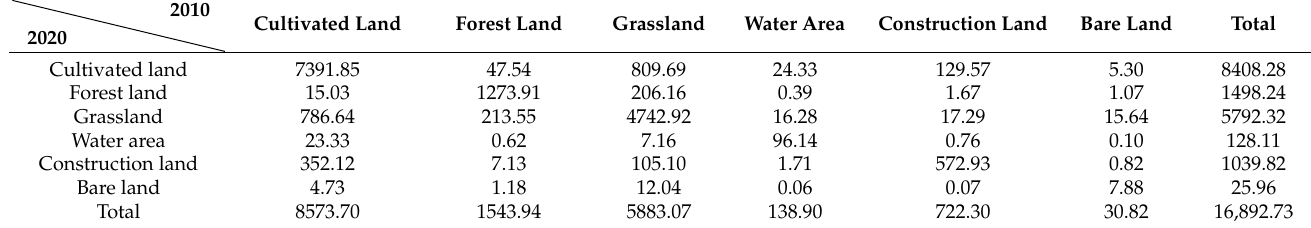
Table 10. The land use transfer matrix in Hohhot from 2010 to 2020 (unit: km 2 ).